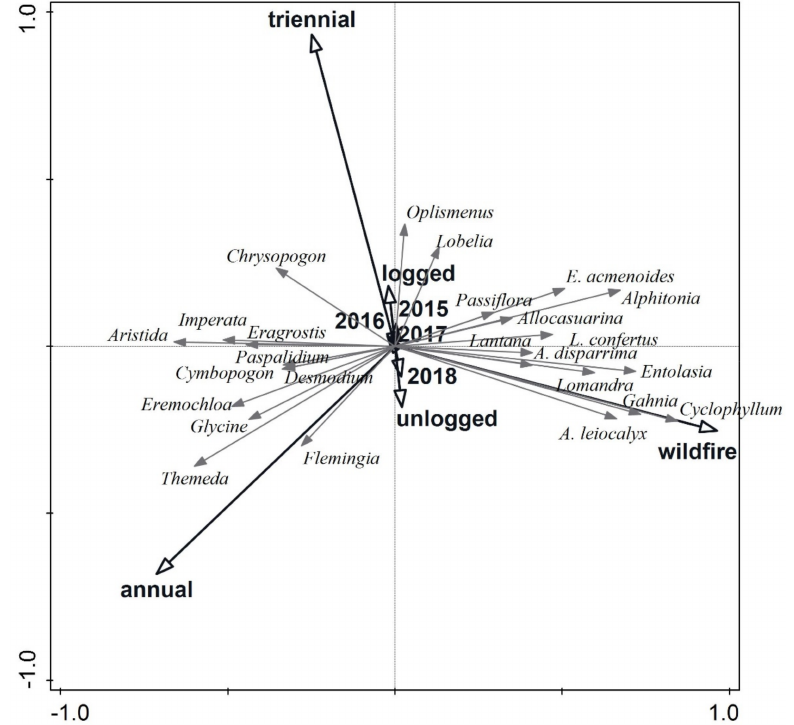
Figure 4. Redundancy analysis output, showing the important influence of fire treatments on taxa composition, with timber harvesting and sampling time having a much smaller influence. The 25 taxa that were best explained by the model are included. These were: Flemingia , F. parviflora ; Themeda , T. triandra ; Glycine , Glycine clandestina ; Eremochloa , E. bimaculata ; Desmodium , D. rhytidophyllum ; Cymbo- pogon , C. refractus ; Paspalidium , Paspalidium sp.; Arisitda , Aristida sp.; Eragrostis , Eragrostis sp.; Imperata , I. cylindrica ; Chrysopogon , C. fallax ; Oplismenus , O. aemulus ; E. acmenoides , Eucalyptus acmenoides ; Alphitonia , A. excelsa ; Allocasuarina , A. littoralis ; Lantana , L. camara ; A. disparrima , Acacia disparrima ; Entolasia , E. stricta ; Lomandra , Lomandra sp.; Gahnia , G. aspera ; Cyclophyllum , C. coprosmoides ; A. leiocalyx , Acacia leiocalyx